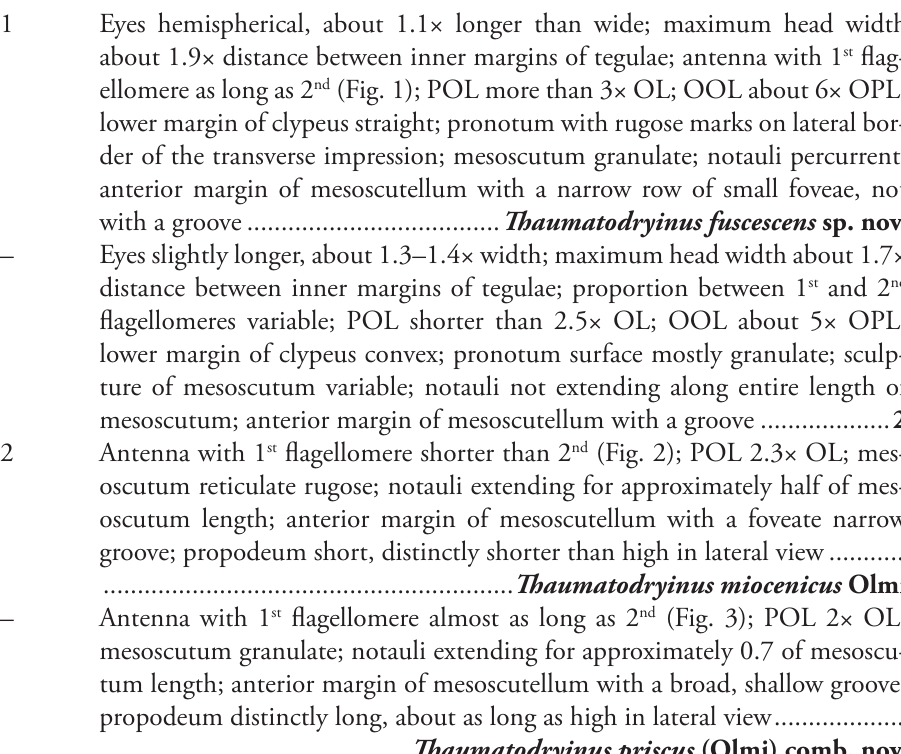
http://zoobank.org/48DD7867-AB75-4443-9346-B7DF4A35C982